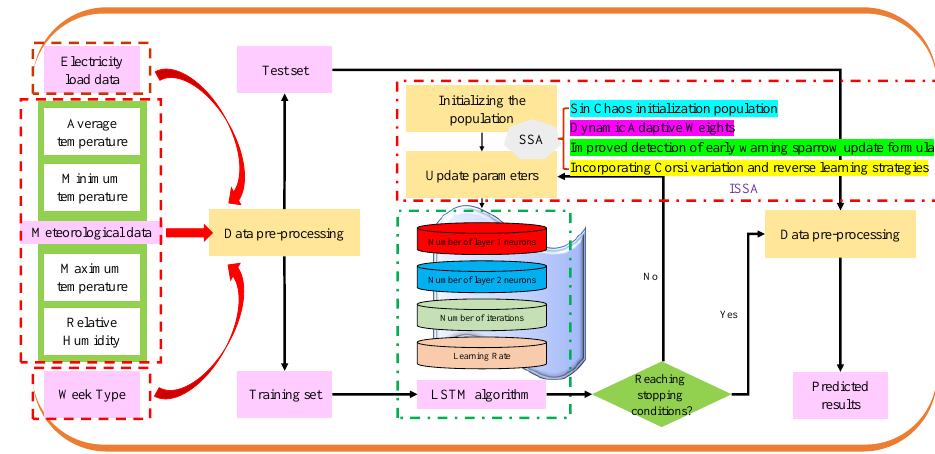
Figure 6. ISSA-LSTM-model-framework structure.